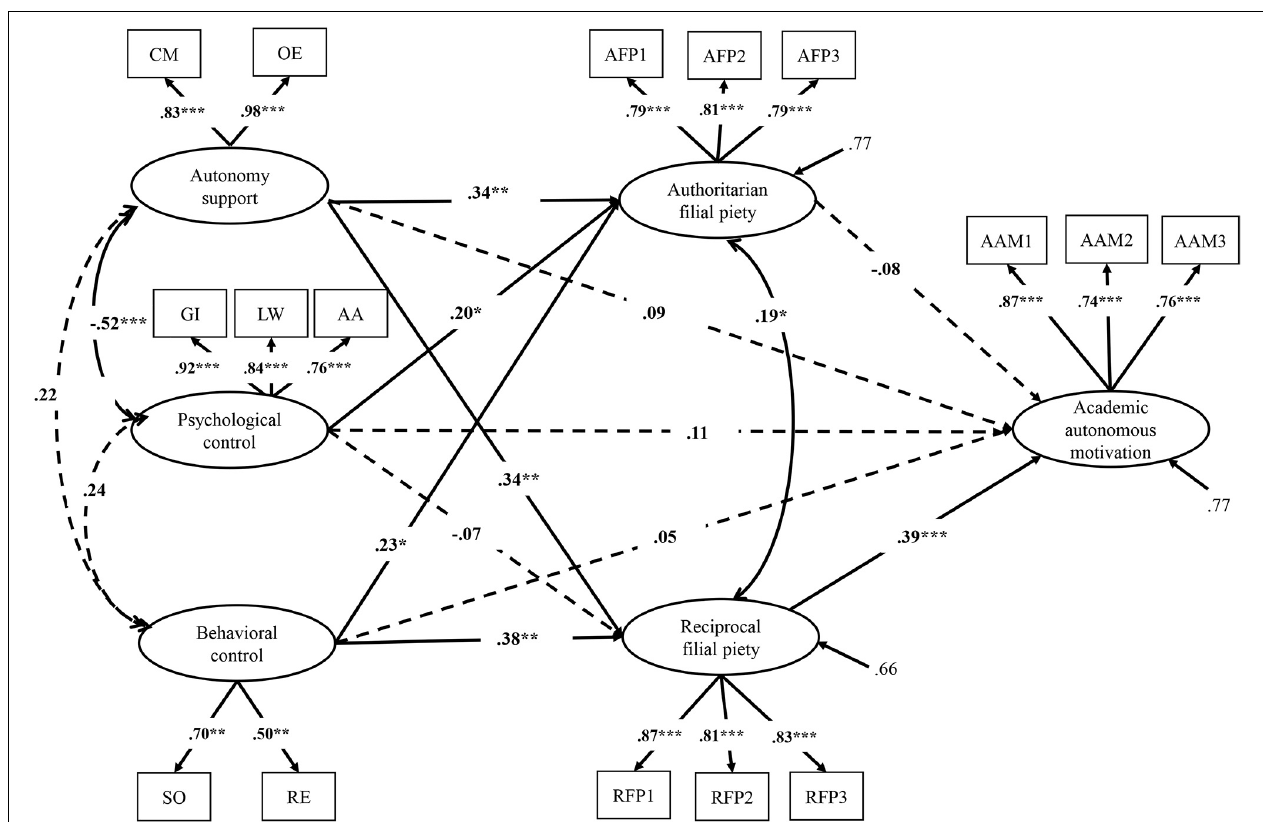
FIGURE 2 | The mediation model of the study variables (Presented are standardized coefficients; CM, choice making; OE, opinion exchange; GI, guilt induction; LW, love withdrawal; AA, authority assertion; SO, solicitation; RE, restriction; AFP, Authoritarian filial piety; RFP, Reciprocal filial piety, and AAM, Academic autonomous motivation; * p < 0.05, ** p < 0.01, *** p <